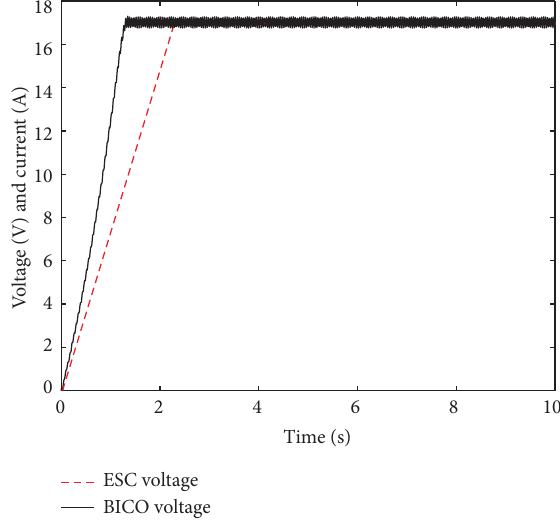
Figure 12: Comparison of voltage tracking in BICO MPPT and ESC MPPT.